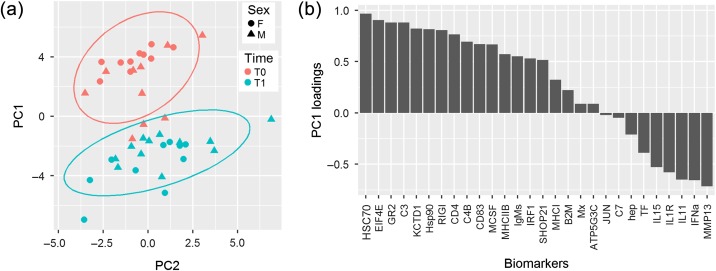
PC analysis of gene expression in gill tissue (28 biomarkers of stress and immunity) at the time of gillnet capture (T0; orange) and 2 days following capture (T1; blue). Ellipses represent 95% confidence intervals for each group cluster. (b) PC loadings of genomic biomarker variables.